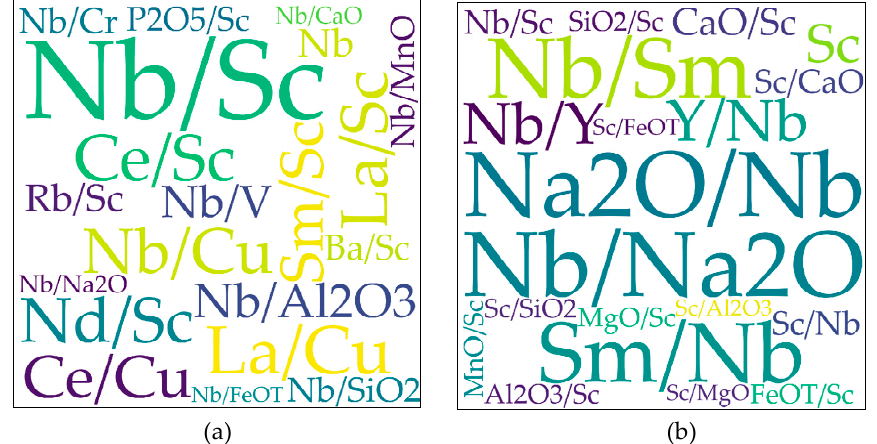
Figure 15. Word clouds of the top 20 important elements (or element ratios) for OIG and non-OIG discrimination diagrams. ( a ) is for linear coordinates; ( b ) is for logarithmic coordinates.